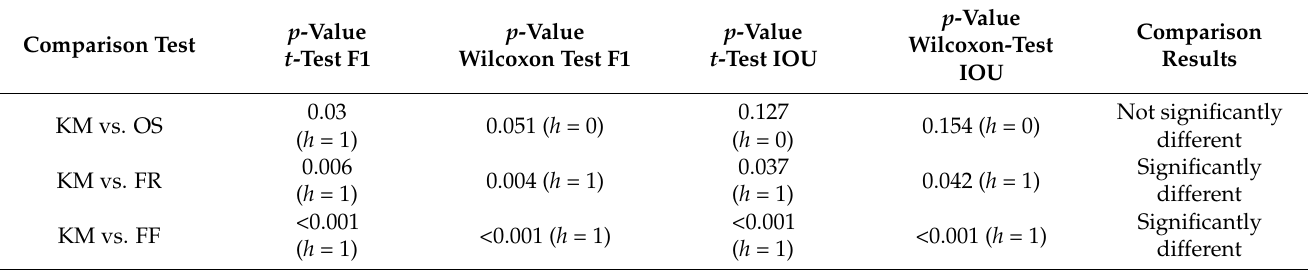
Figure 34. Box-plot of the overall accuracy of all low illuminated and high contrast benthic habitat images segmentation results based on the proposed algorithms: ( a ) F1-score; ( b ) IOU values. Table 3. Comparison of statistically significant differences in F1-Score and IOU results between the proposed algorithms with a confidence of